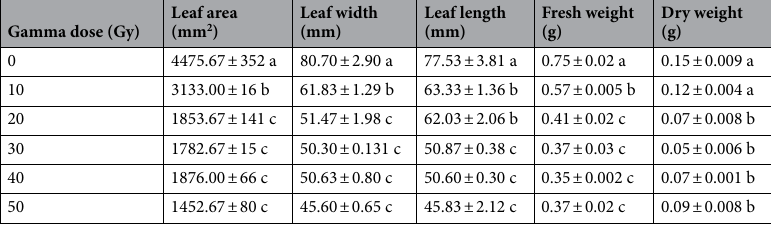
Table 2. The effects of different gamma irradiation doses on leaves morphometric traits of ‘Yaghouti’ grape ( Vitis vinifera L.) cultivar. The means with same Duncan’s multiple range test letters in each column are not statistically significant ( P ≤ 0.01). Data are average of four replications ±